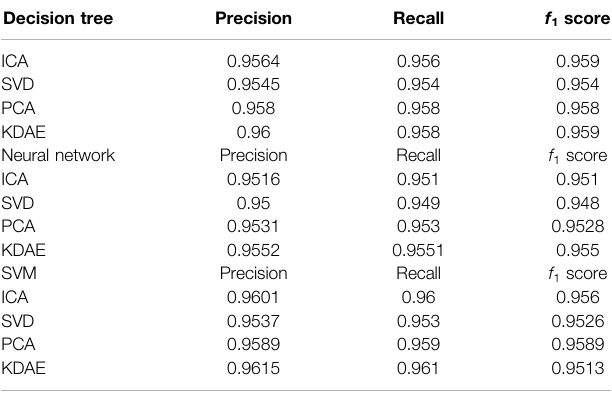
TABLE 3 | Detect data in 16 dimensions. Decision tree